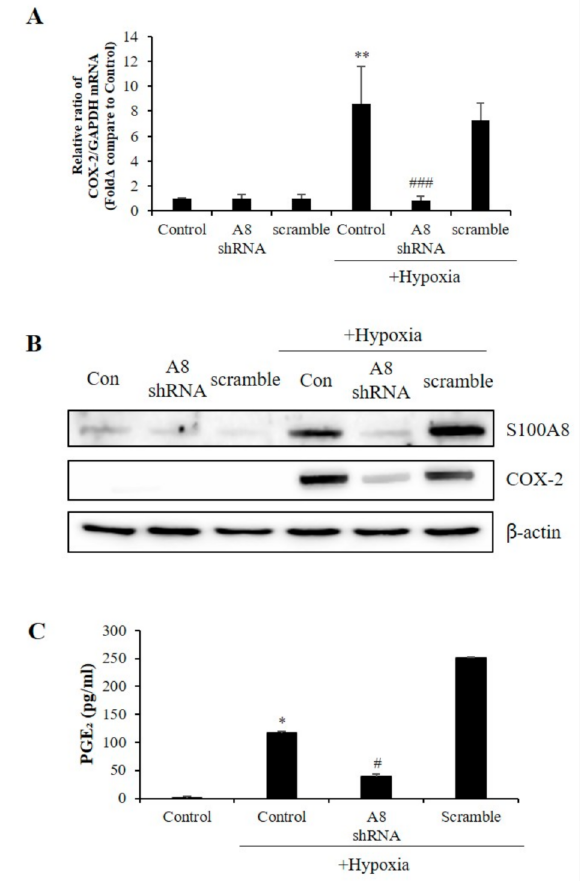
Figure 6. The expression of S100A8 in microglial cell induces the Cyclooxygenase-2 (COX-2) /prostaglandin E2 (PGE 2) pathway. BV-2 cells were transfected with S100A8 shRNA or Scram- ble vector. After 24 h, cells were incubated in hypoxic condition for 48 h. ( A ) The mRNA and ( B ) the protein levels of S100A8 and COX-2 were detected by real-time PCR and western blotting. ( C ) Se- cretion of PGE 2 level analyzed by ELISA. Data from three independent experiments are presented as the means ± S.D. Values of * p < 0.05, ** p < 0.01 versus control; # p < 0.05, ### p < 0.001 versus hypoxia-exposed sample were considered as statistically